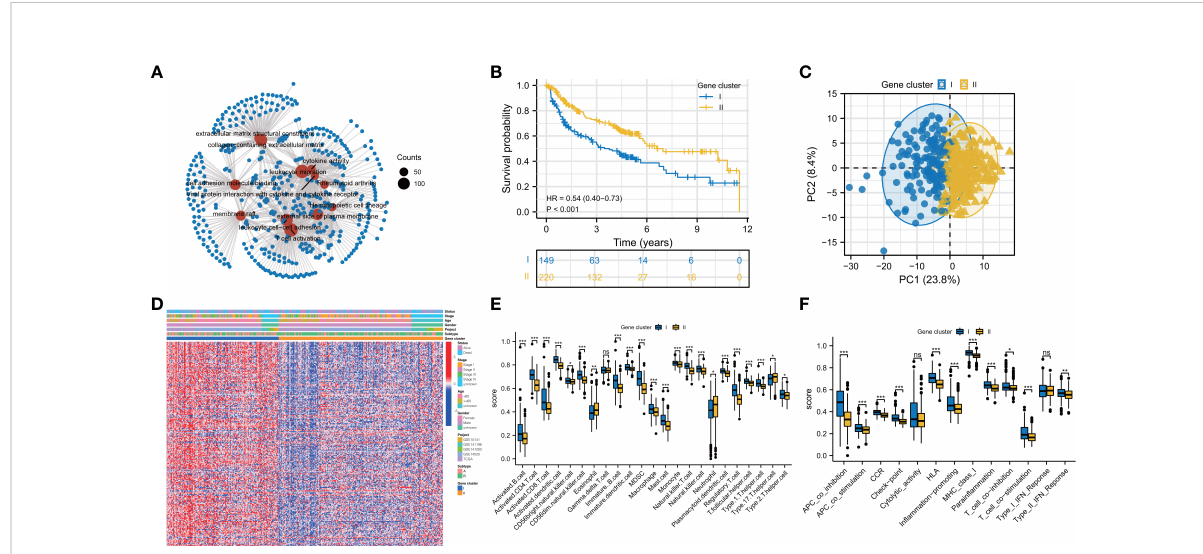
FIGURE 3 Prognosis and immune landscape between pyroptosis gene clusters for HBV-HCC patients. (A) GO and KEGG enrichment analysis for DEGs between two subtypes. (B) Survival curves of the two gene clusters. (C) PCA plot based on the expression of prognostic prognosis-related DEGs from pyroptosis clusters veri fi ed the two gene clusters, I (blue) and II (orange). (D) Clinical characteristics of gene clusters were shown by heatmaps. (E, F) The immune in fi ltrations (E) and functions (F) scores between the two gene clusters. DEGs: differentially expressed genes; *P < 0.05; **P < 0.01; ***P < 0.001; ns, not statistically signi fi